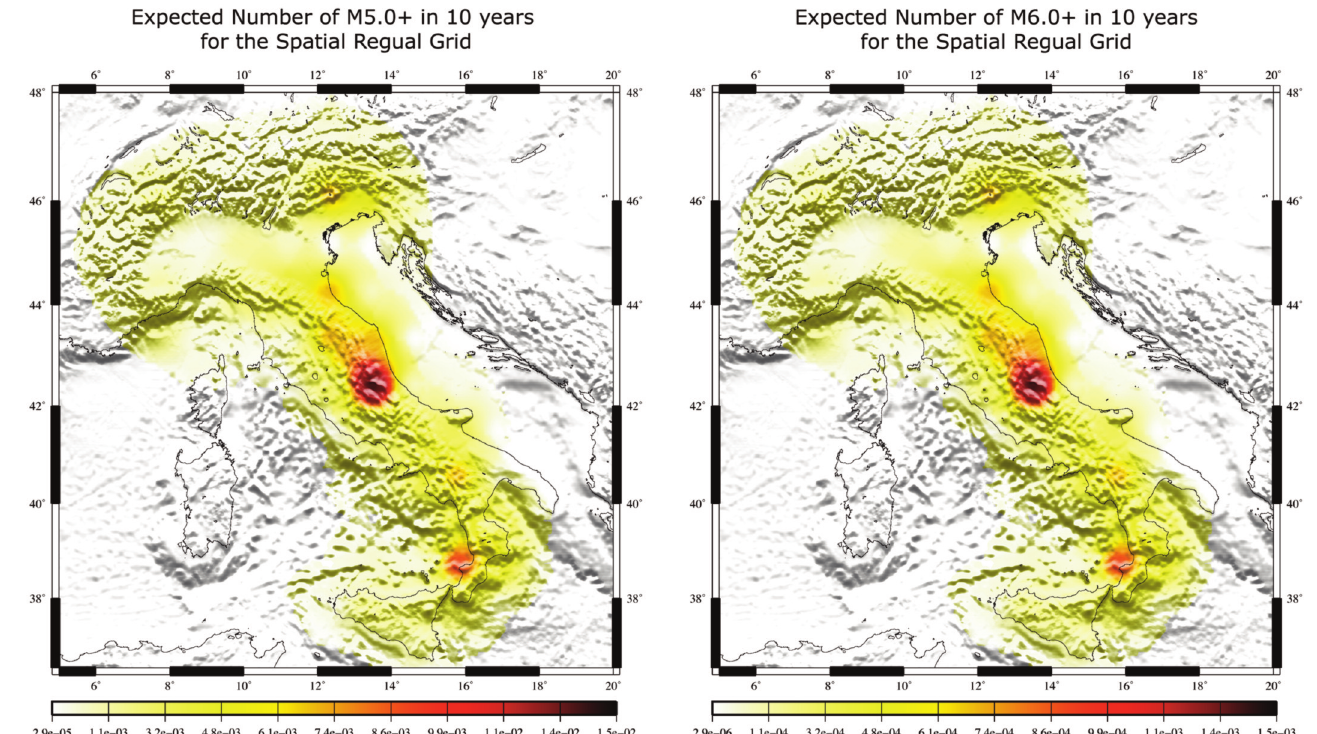
Figure 7. The number of expected events in the surface units of the CSEP testing grid for the spatial geometrical grid: left, M